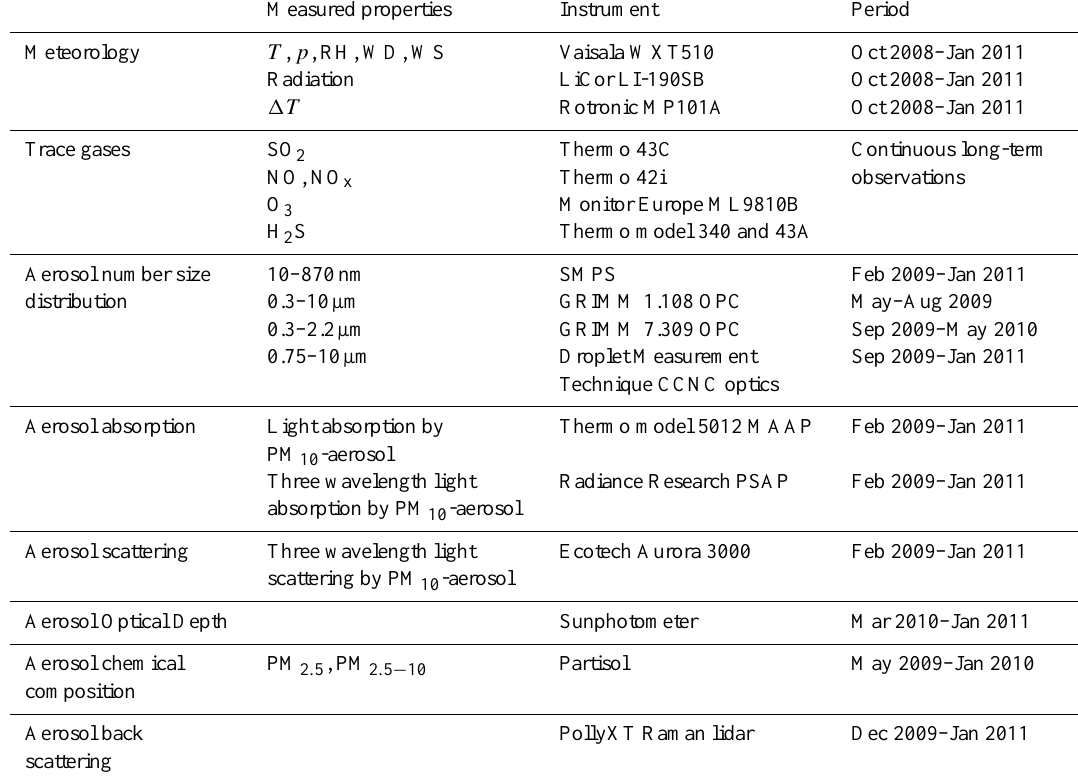
Table 1. Measured parameters and